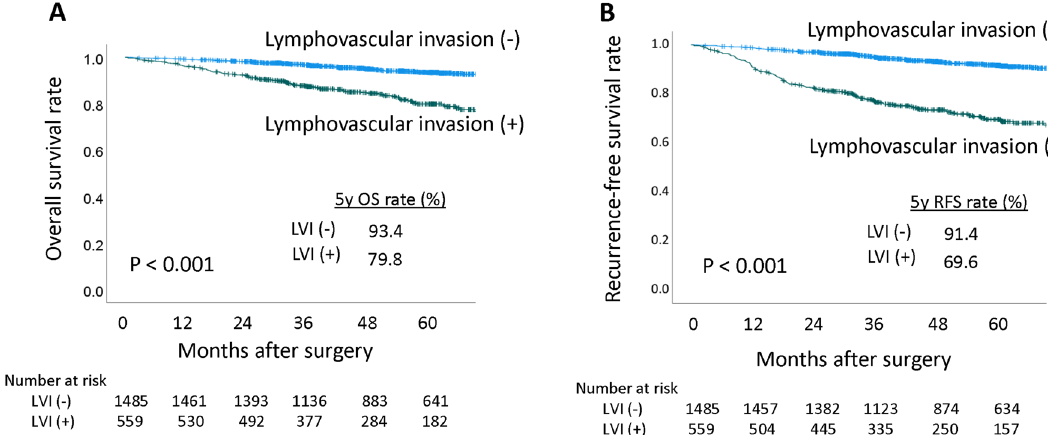
Figure 2. ( A ) Overall survival curves of patients with vascular invasion ( +) and vascular invasion ( −). ( B ) Recurrence-free survival curves of patients with vascular invasion ( +) and vascular invasion (–). OS overall survival, LVI vascular invasion, RFS recurrence-free survival.